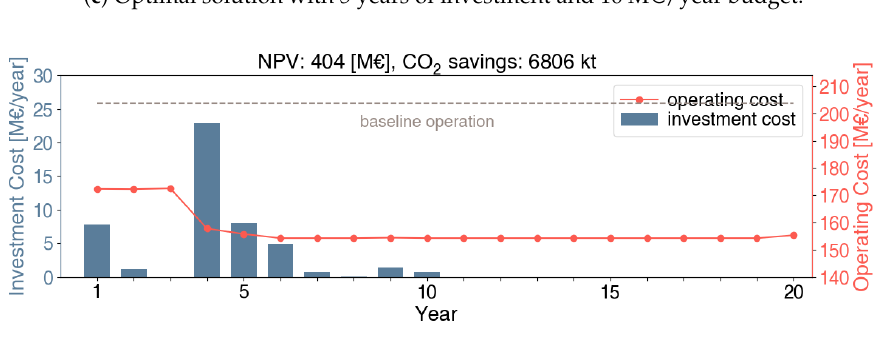
Figure 11. Comparison of operating and investment costs of the optimal solutions with the